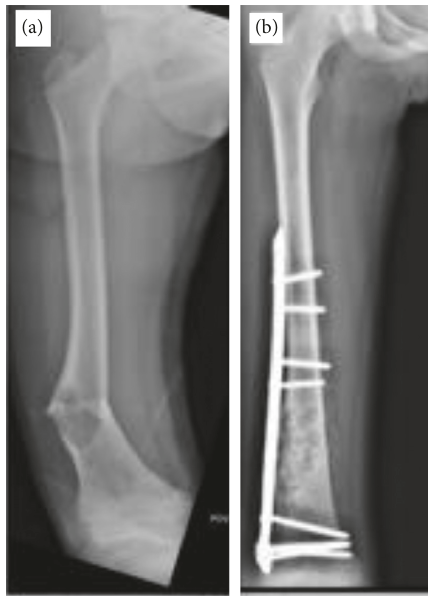
Figure 2: (a) AP X-ray with pathological fracture through a di- aphyseal ABC. (b) AP X-ray after intralesional resection/curettage followed by fracture fixation with plate and screws.